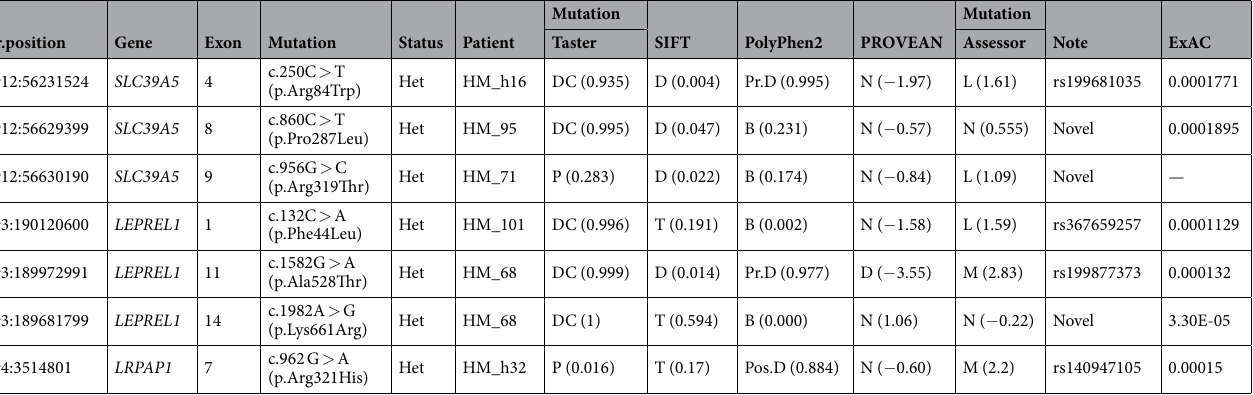
Table 2. Summery of Mutations in LEPREL1 , SLC39A5 and LRPAP1 . Notes: Het, heterozygous; Mutation taster (DC, disease-causing; P, polymorphism); SIFT (D, damaging; T, tolerated); PolyPhen2 (Pr.D, probably damaging; pos.D, possible damaging; B, benign); PROVEAN (D, deleterious; N, neutral); MutationAssessor (M, medium; L, low; N,